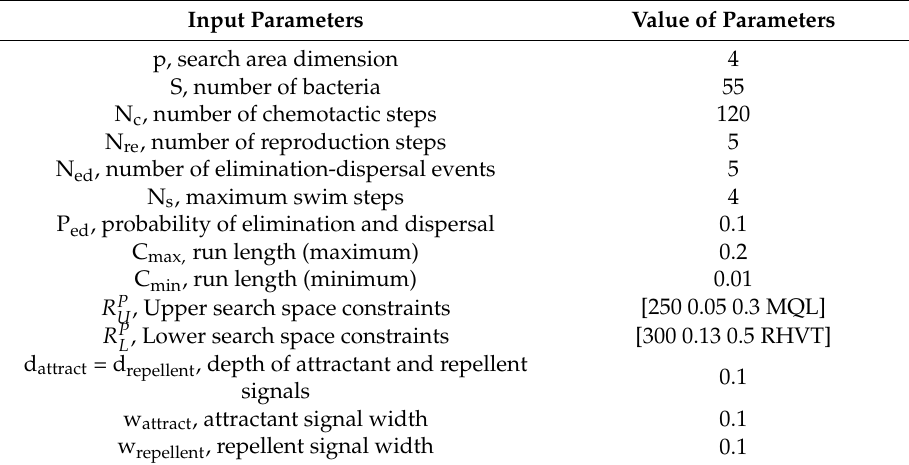
Table 6. Parameters of bacteria foraging optimization